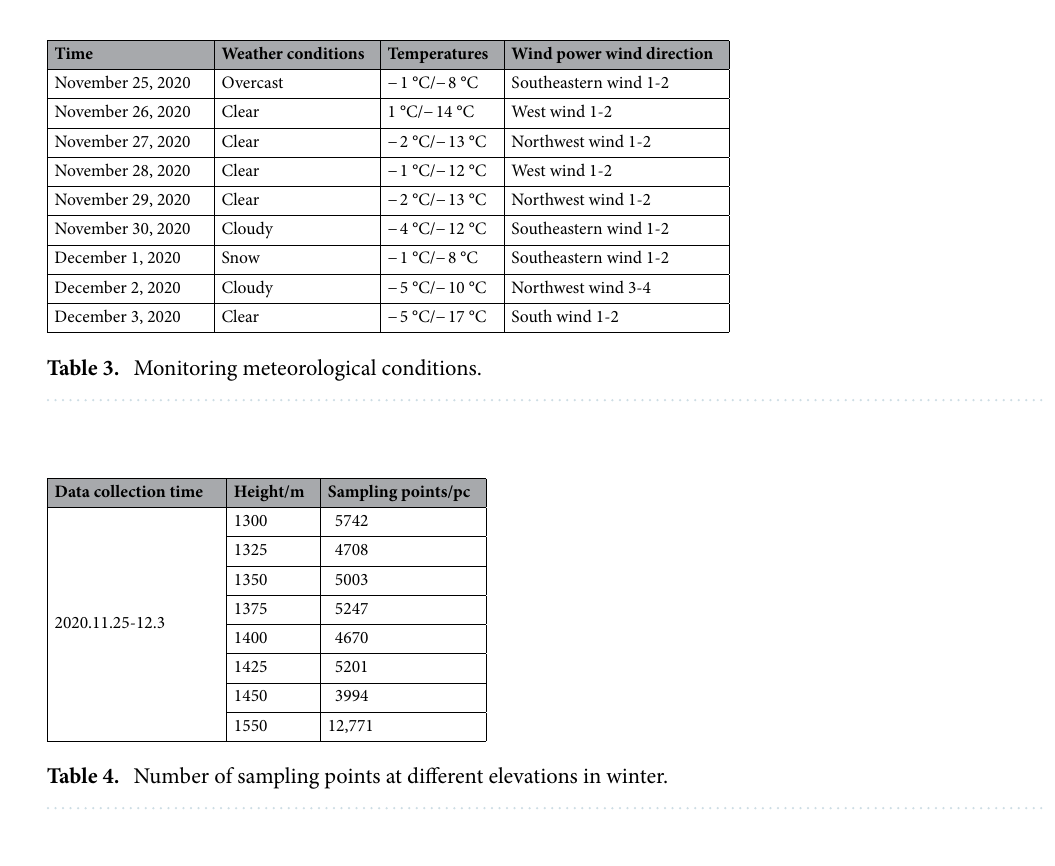
Figure 4. UAV route planning. Maps were created using WPS for Windows (version 11.1.0.13703. https:// www. wps. cn), the original image freely available in Amap (https:// www. amap. com).